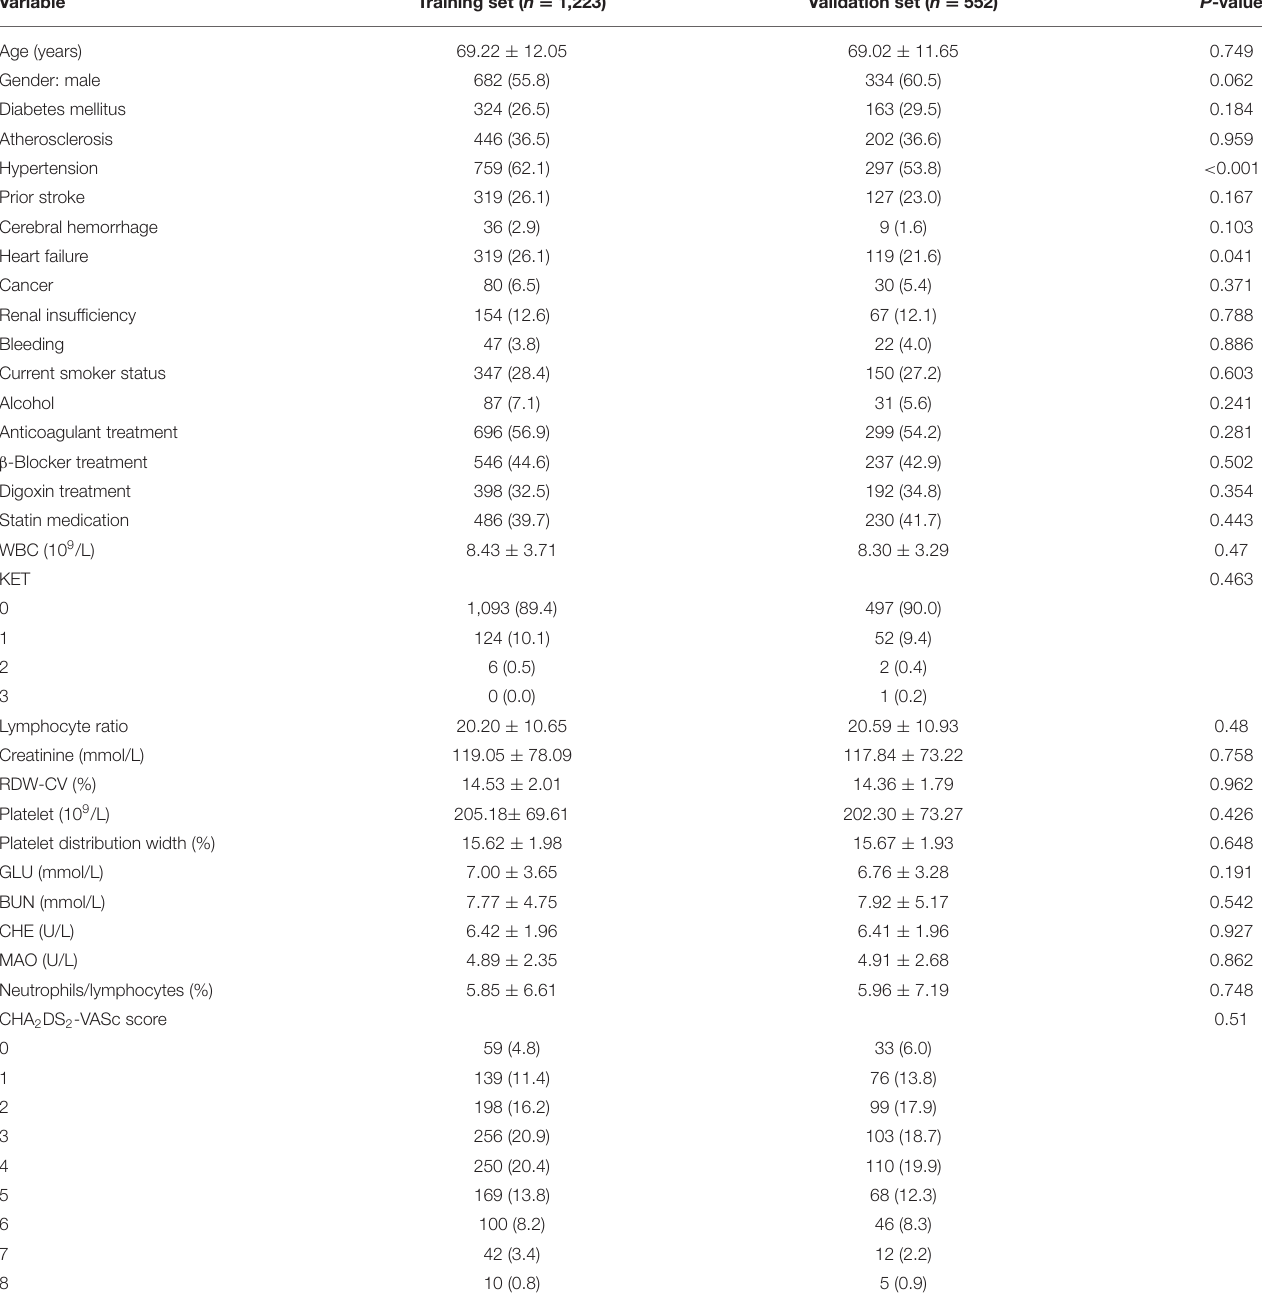
TABLE 1 | Baseline characteristics of the AF prospective cohort.